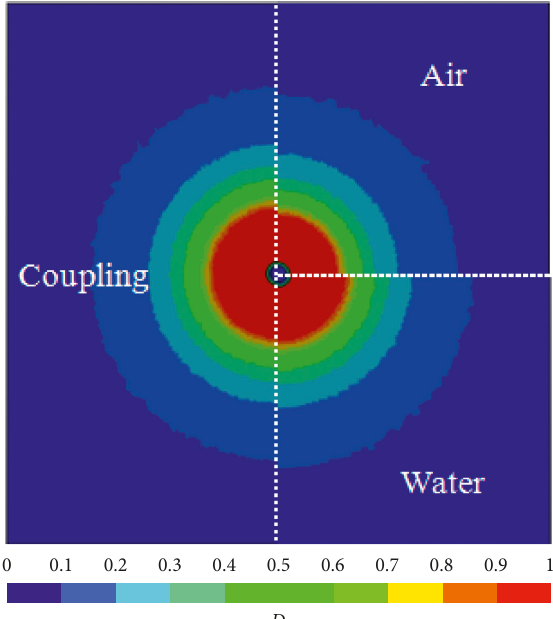
Figure 16: The rock mass damage degree comparison with dif- ferent uncoupling media.